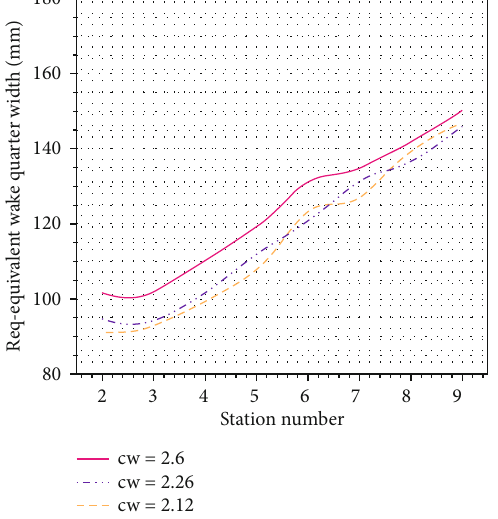
Figure 14: Equivalent quarter-width variations at di ff erent stations for 3 characteristic